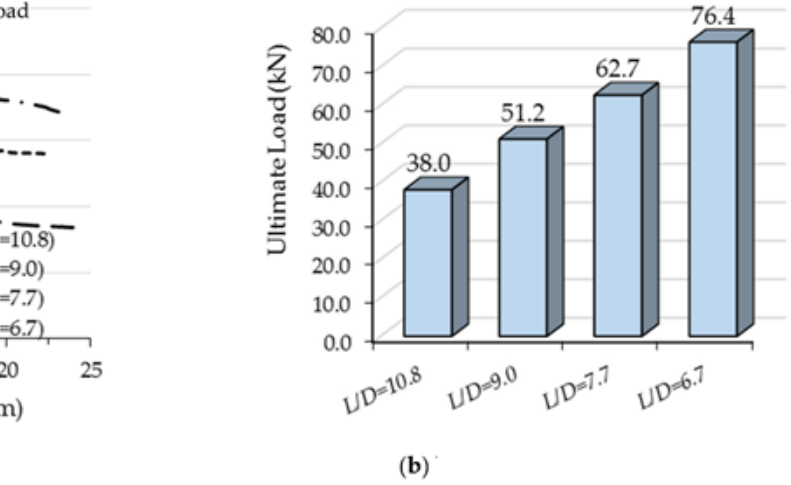
Figure 22. Comparison of the results of FE models with varied length-to-depth ratios ( L / D ): ( a ) Load-deflection relationship; ( b ) Ultimate load.